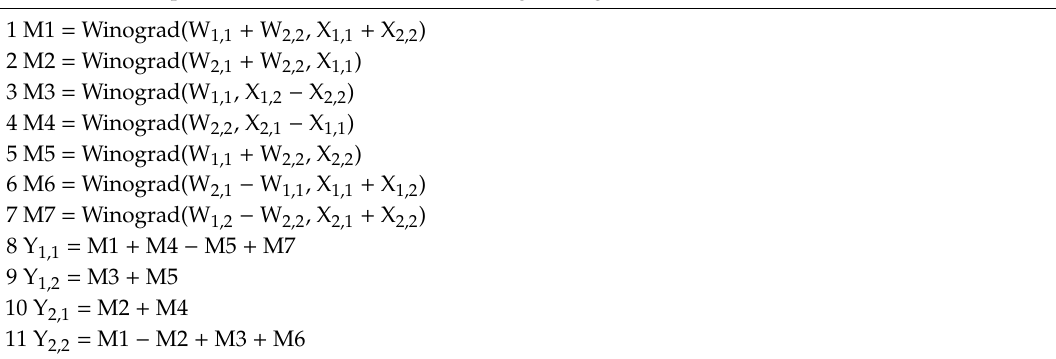
Algorithm 2. Implementation of the Strassen–Winograd Algorithm